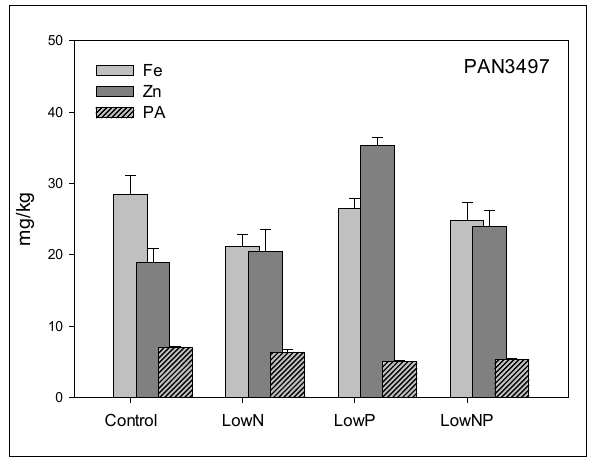
Figure 1: The Fe, Zn and phytic acid contents of PAN3497 under four treatments over two years. Values are means ± s.d. ( n =6).